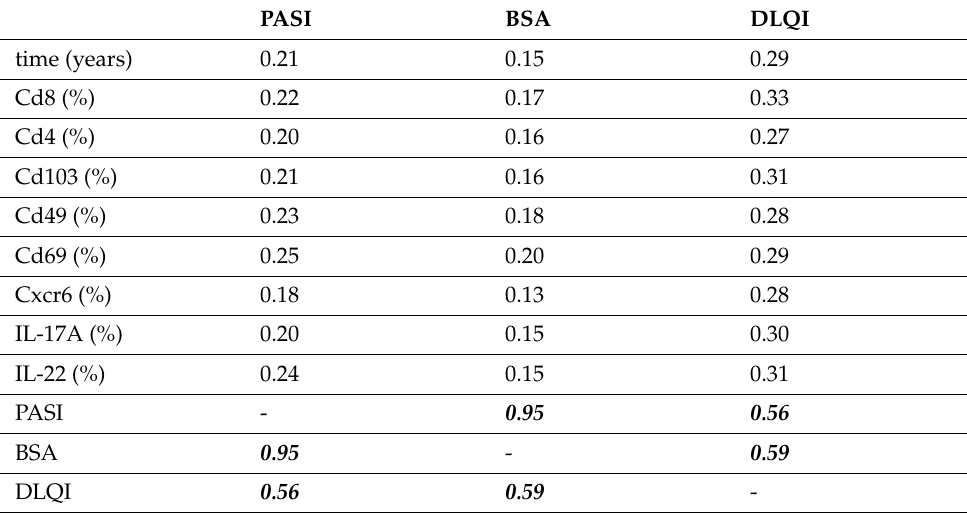
Table 4. Correlation coefficient (r) between the analyzed variables: time, intensity, and expression. Statistically significant correlations are marked in italics and